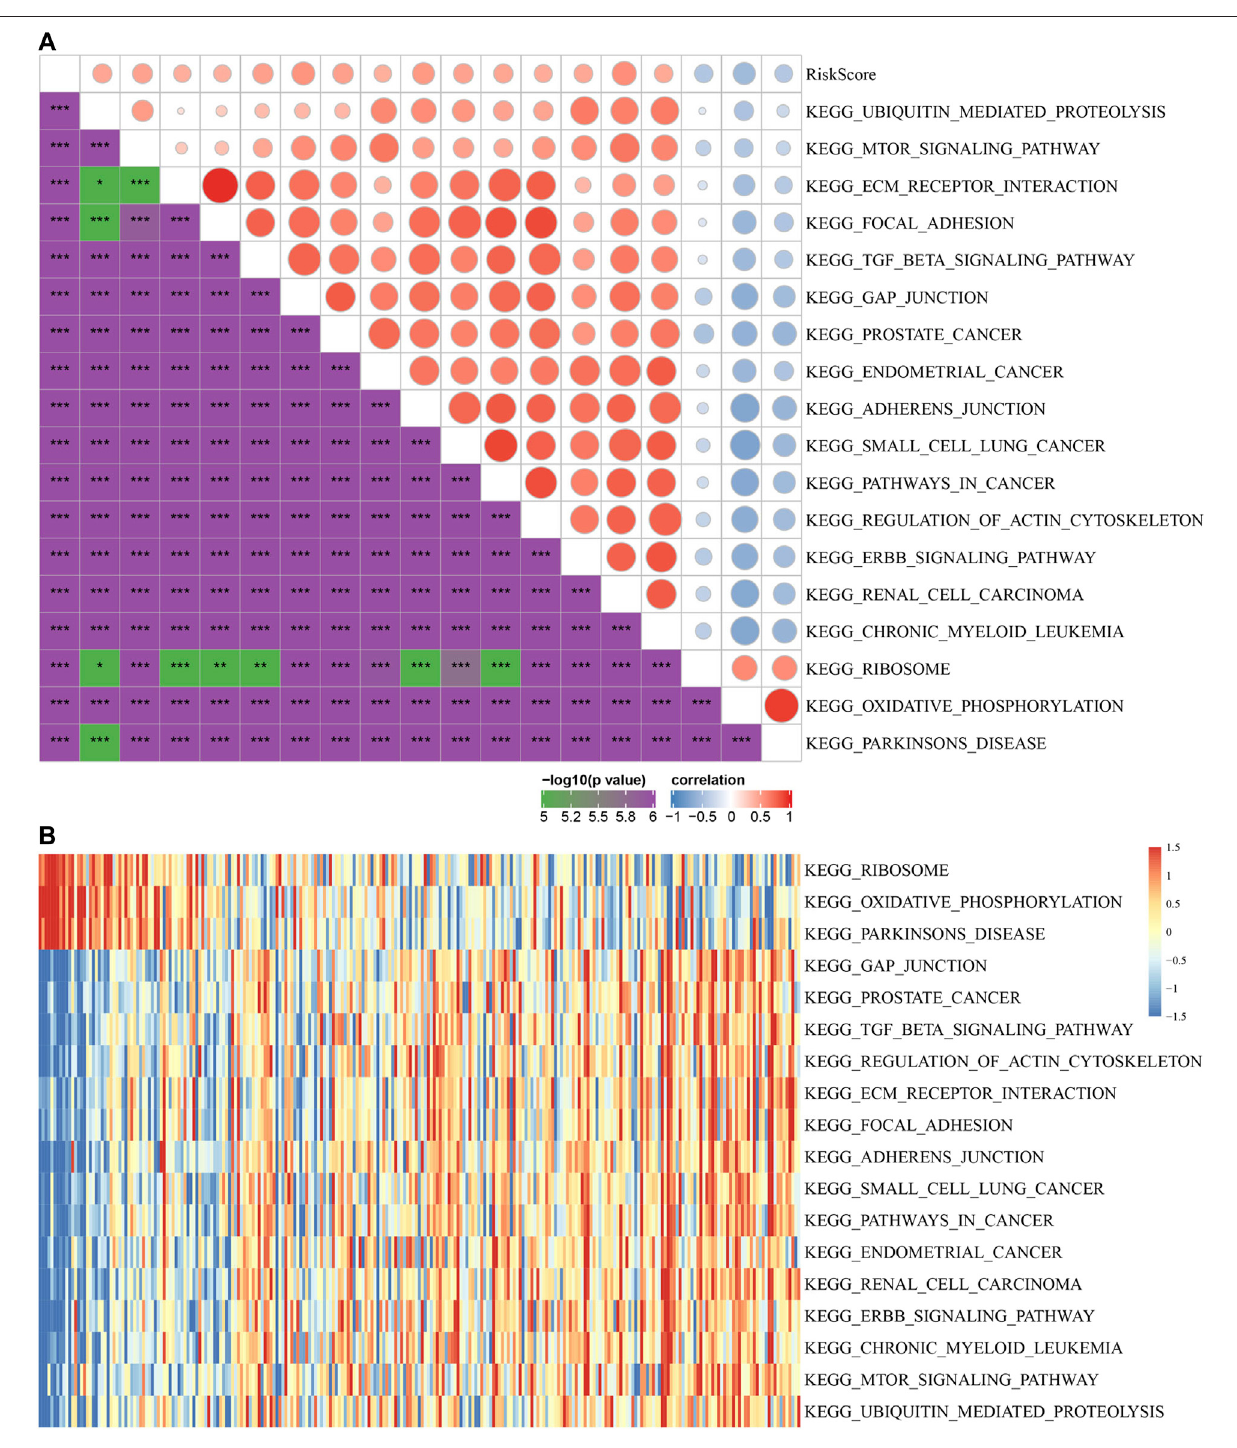
FIGURE 8 | The relationship between risk score and KEGG pathways. (A) Correlation coef fi cient clustering between KEGG pathways and risk score with a risk score correlation greater than 0.4. (B) GSVA revealed KEGG pathways associated with the risk score. The horizontal axis represents the sample, and the risk score increases from left to